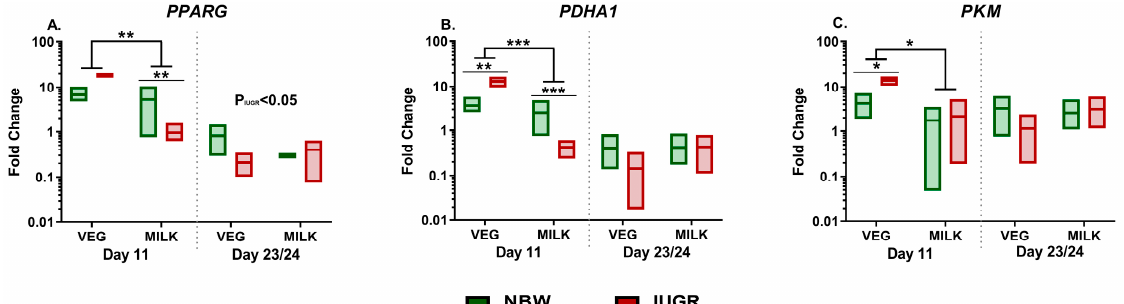
Figure 4. Expression of genes related to cellular metabolism in animals fed either vegetable (VEG, n = 6–8) or milk fat (MILK, n = 7–9) further stratified into normal birthweight (NBW, n = 7–8) or intrauterine growth restricted (IUGR, n = 6–9) animals. ( A – C ) Expression of PPARG , PDHA1 and PKM in whole blood stimulated with Staphylococcus epidermidis , shown as relative gene expression. All results presented as range plots with corresponding medians. *: Effect of diet, ***: p < 0.001, **: p < 0.01, *: p < 0.05. Main effects of birthweight across diet groups are shown in the figures as P IUGR .